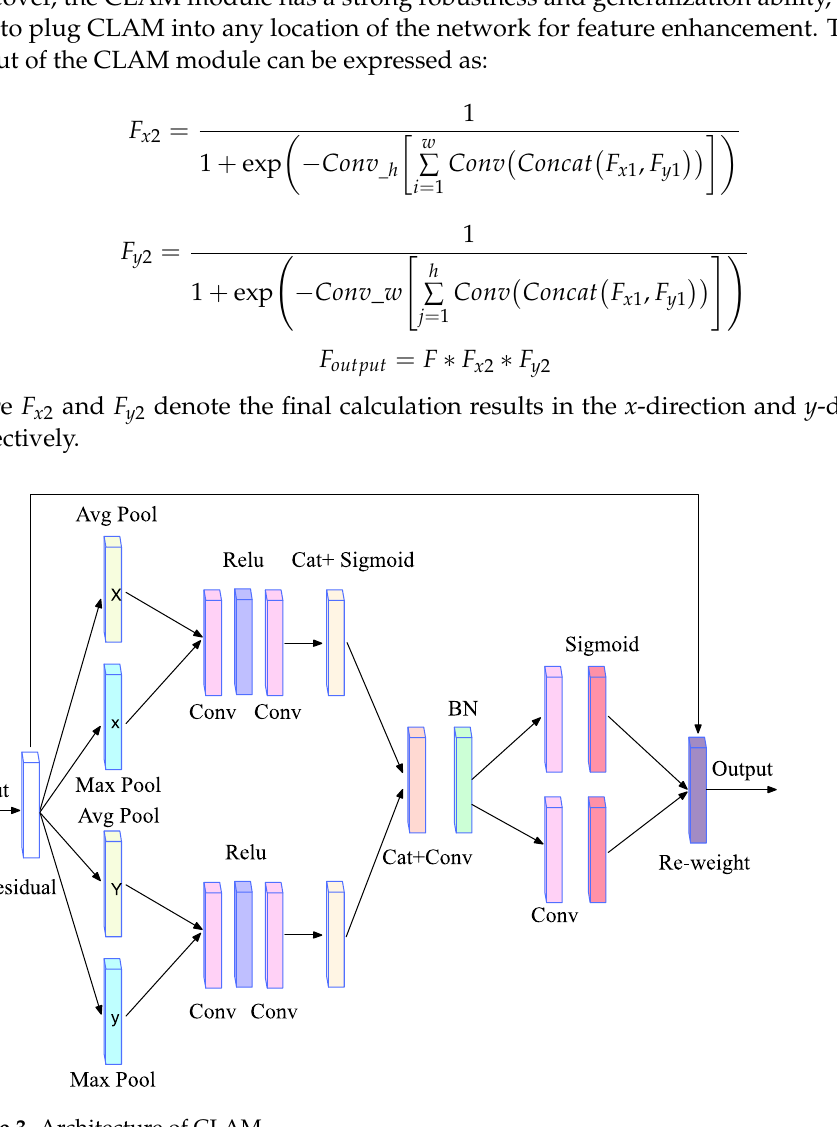
Figure 3. Architecture of CLAM.